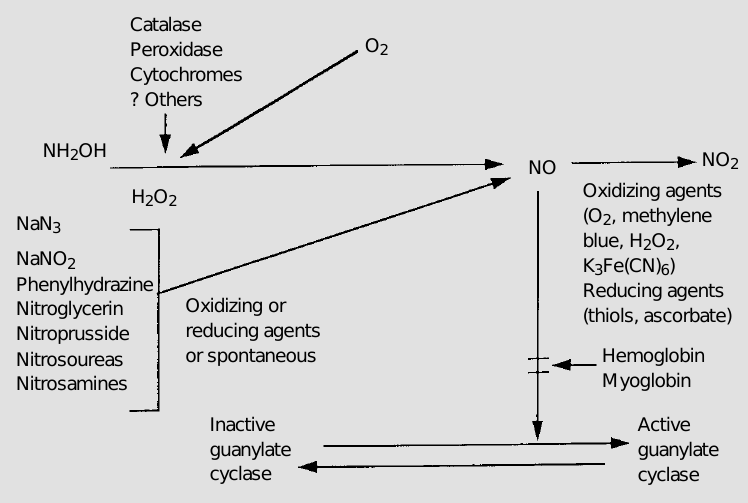
Figure 2 - Effects of nitrovasodilators on cyclic GMP synthesis. From Refs. 13 and 15, with